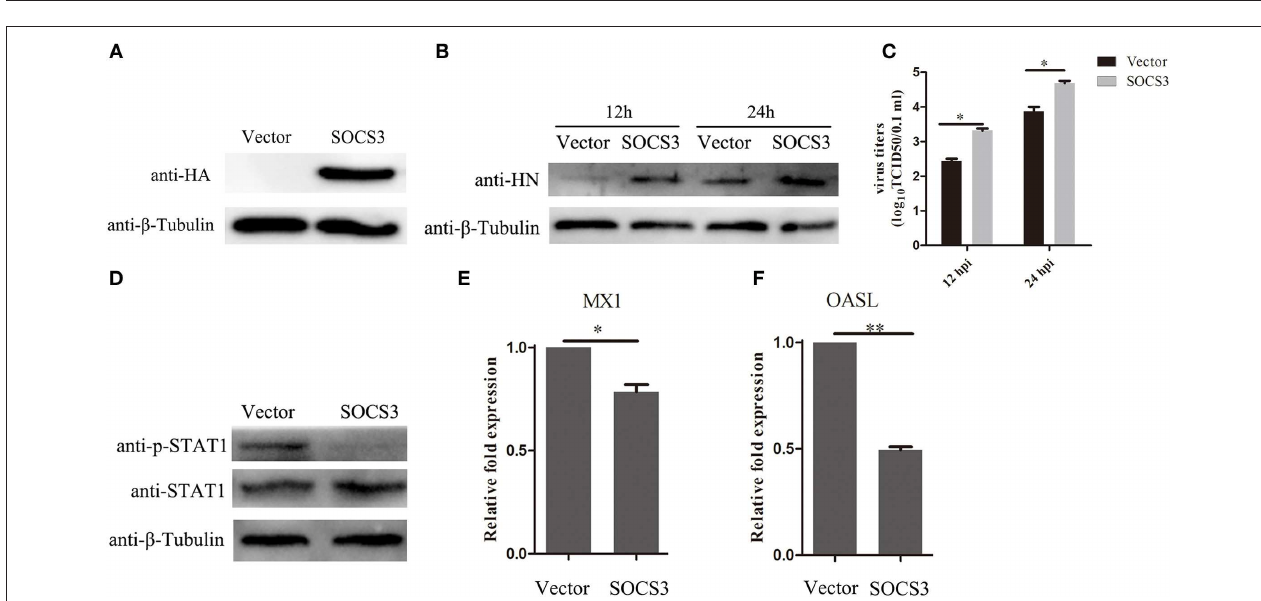
FIGURE 3 | NDV V protein plays a vital role in upregulating the expression of SOCS3. (A–C) CEF cells were transfected with plasmids expressing FLAG-tagged NDV genes. Cells were harvested and qRT-PCR and WB were performed to detect the expression of SOCS3 24h post transfection. (D,E) CEF cells were transfected with pCAGGS-Flag (Vector) and pCAGGS-Flag-V (1, 2 µ g). Cells were harvested and qRT-PCR and WB were performed to detect the expression of SOCS3 24h post transfection. (F,G) CEF cells were transfected with pCAGGS-Flag (Vector) and pCAGGS-Flag-V (V), pCAGGS-Flag-VN (VN), and pCAGGS-Flag-VC (VC). Cells were harvested and qRT-PCR and WB were performed to detect the expression of SOCS3 24h post transfection. Data presented are from three independent experiments and presented as mean ± SD. * P < 0.05; ** P < 0.01.